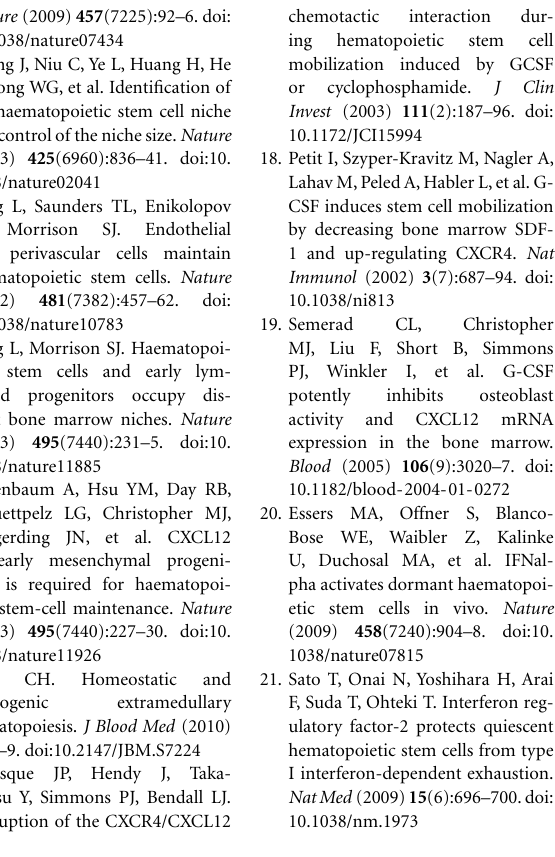
on HSCs or indirectly via stromal cells in the stem cell niche to affect HSCs. Short-term signaling induces HSC proliferation and myeloid differentiation, supplying effector cells of the innate immune response. Sustained exposure to these signals, however, reduces HSC long-term repopulating activity and self-renewal and may contribute to bone marrow failure and/or malignancy.